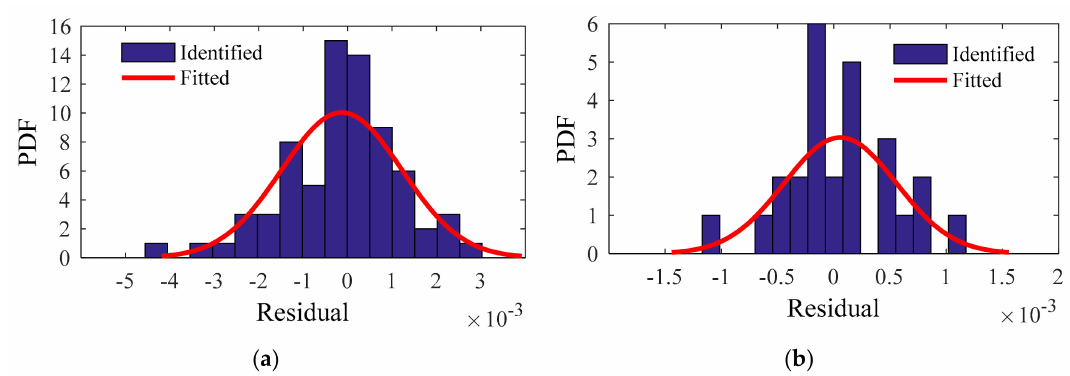
Figure 20. Third modal frequency: identified PDF and fitted PDF of the residual: ( a ) Training sample; ( b ) Testing